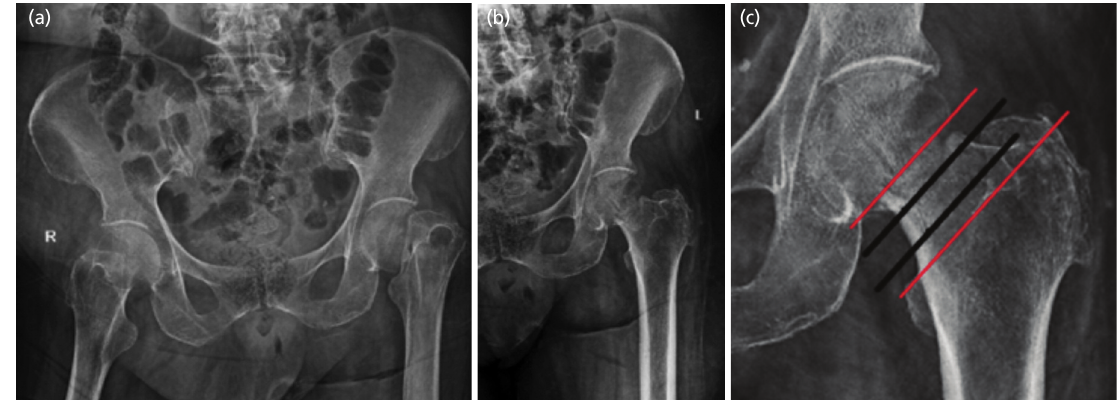
(a, b, c) Radiographs depicting 82-year-old female with Singh index grading 3 who sustained a Fig. 5: